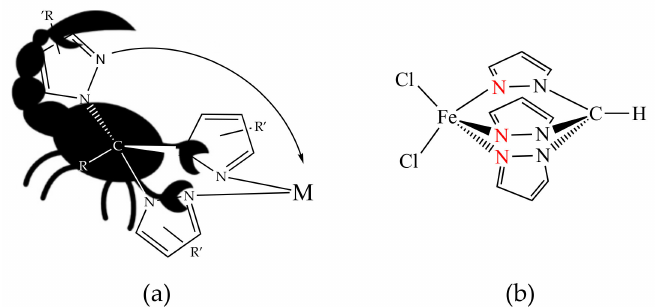
Figure 1. ( a ) Analogy between a C-scorpionate coordination to a metal center (M) and the attack of a scorpion on its prey. ( b ) Structure of the dichloro hydrotris(1 H -pyrazol-1-yl)-methane Fe(II) complex [FeCl 2 { κ 3 -HC(pz) 3 }] (pz = 1 H